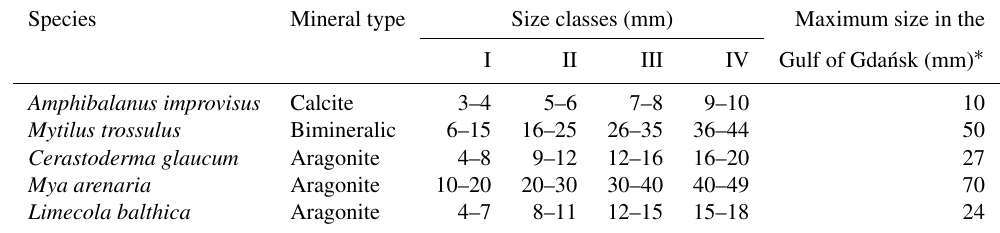
Table 2. The range of shell sizes for each studied species within a given size class. Species Mineral